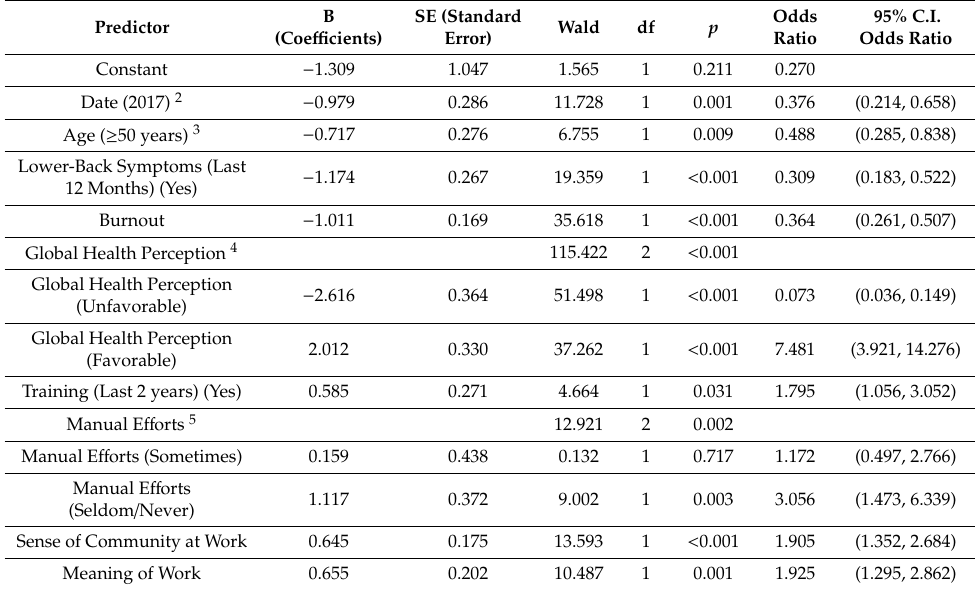
Table 8. Logistic regression model for WAI (1 = excellent, 0 = unsatisfactory) 1